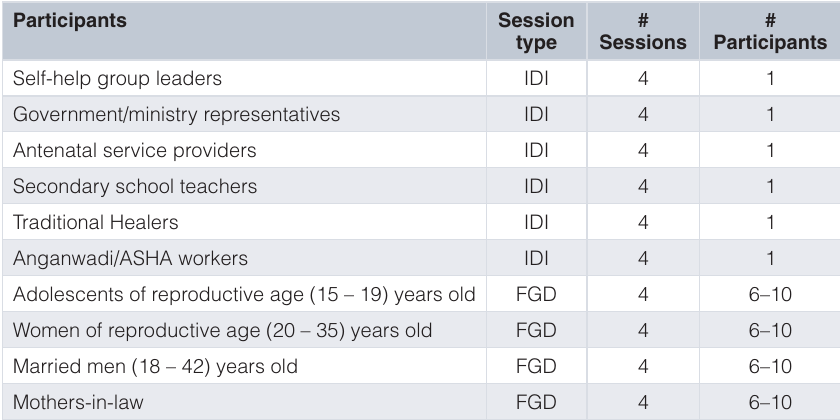
Table 1. Expected Number of interviews and focus groups. Preliminary Schedule of Focus Group Discussions (FGDs) and In-depth Interviews